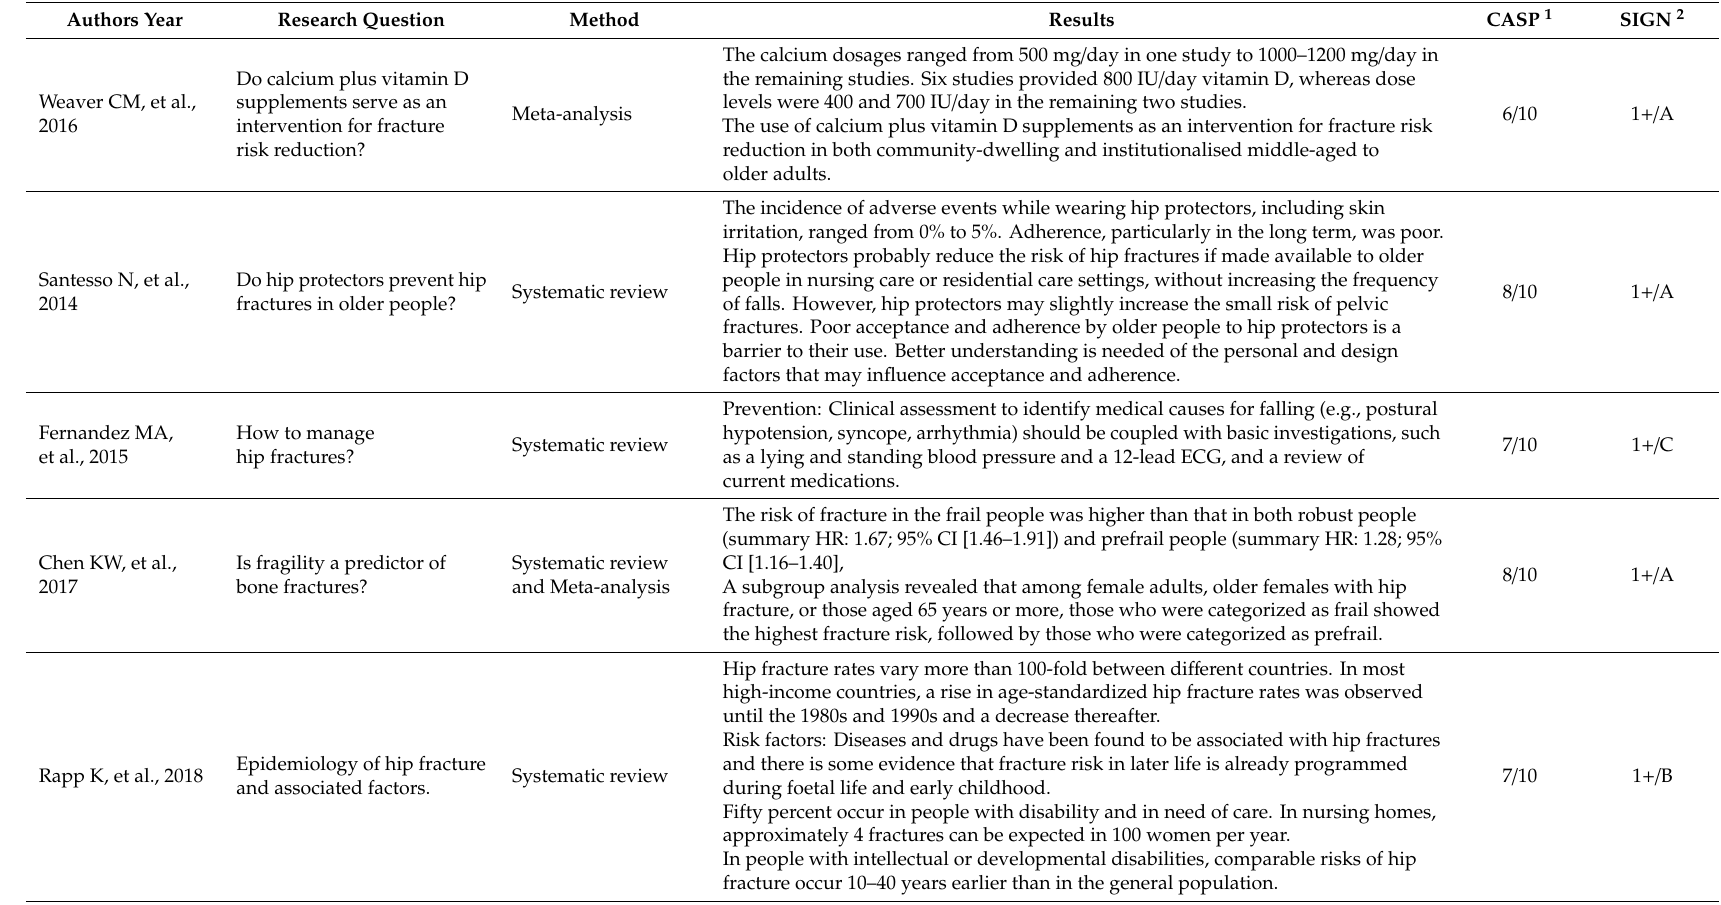
Table 2. Results from review